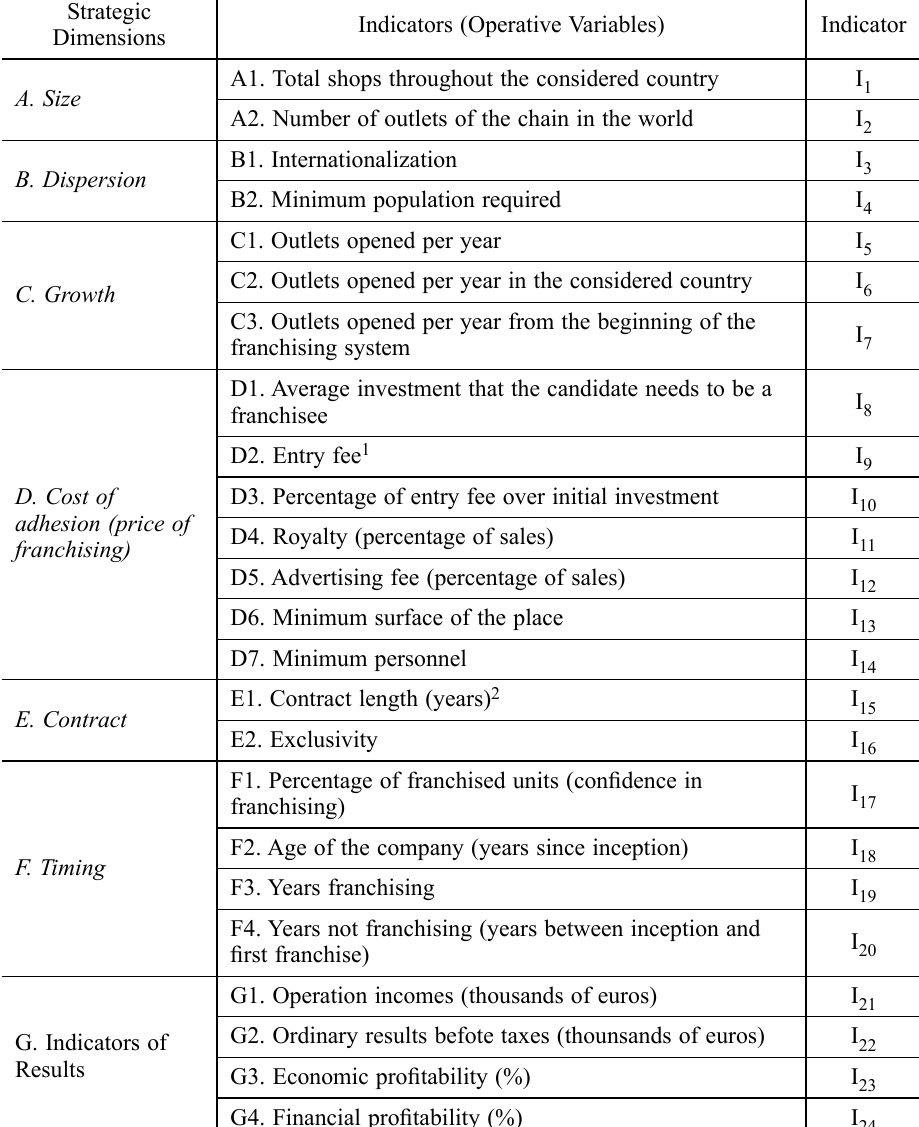
Table 1. Strategic dimensions and